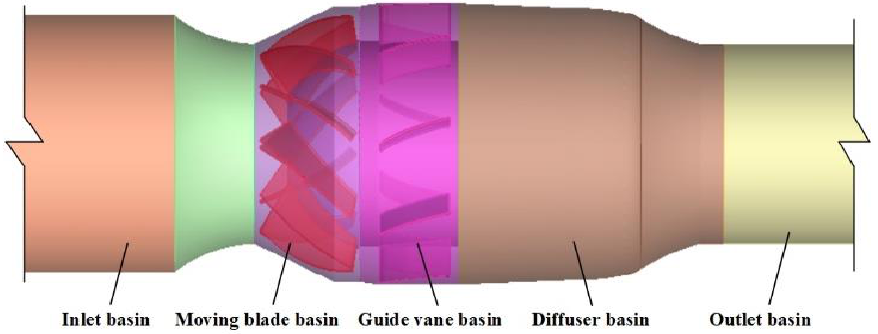
Figure 1. Physical model of small diagonal flow fan.